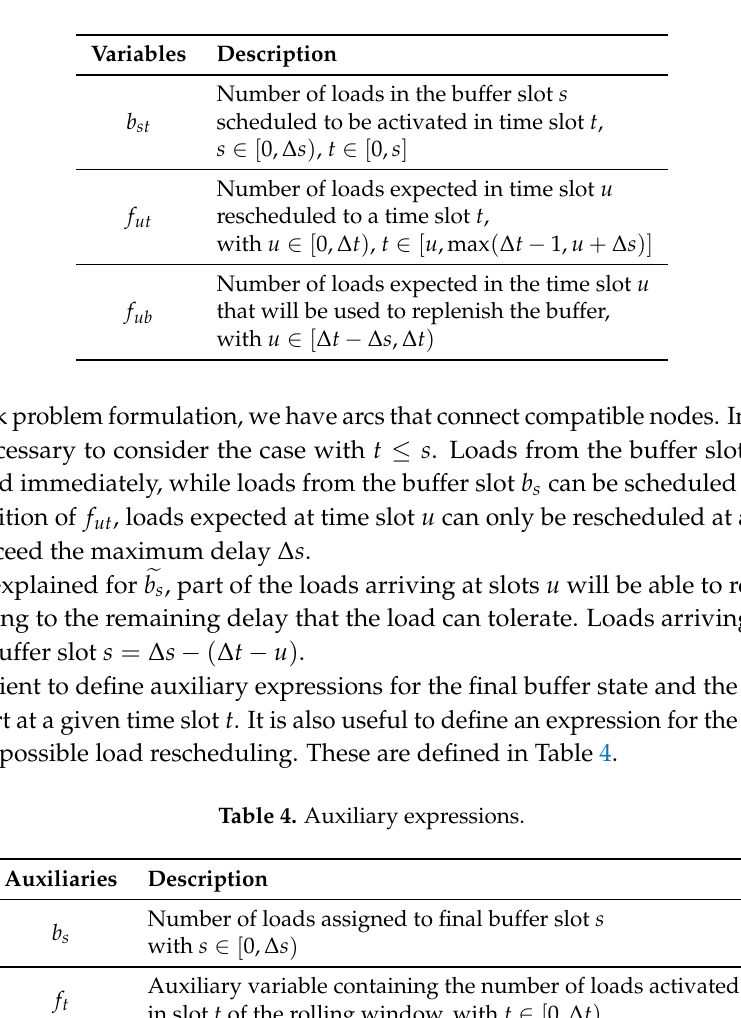
Table 3. Main variables.